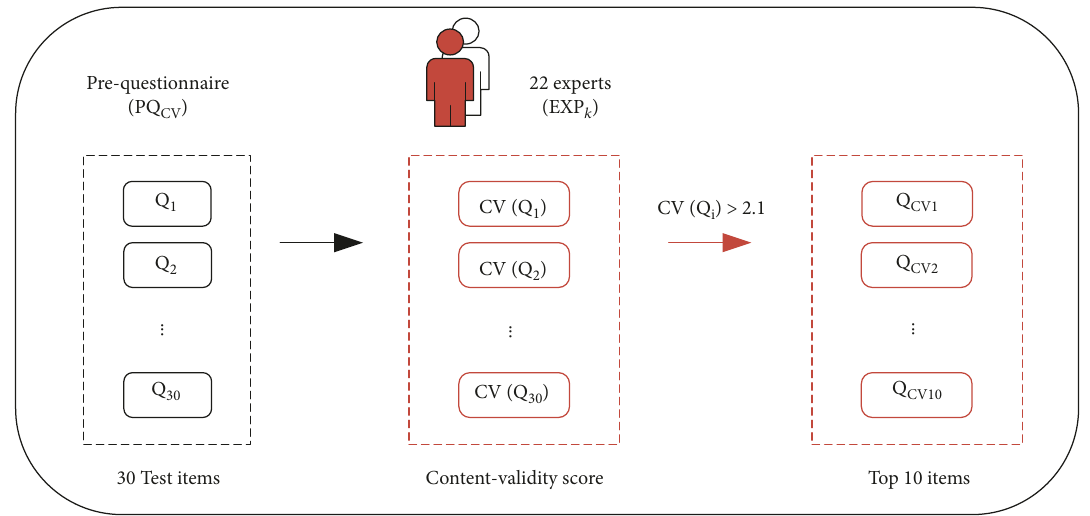
Figure 4: The process of content validation for questions Q